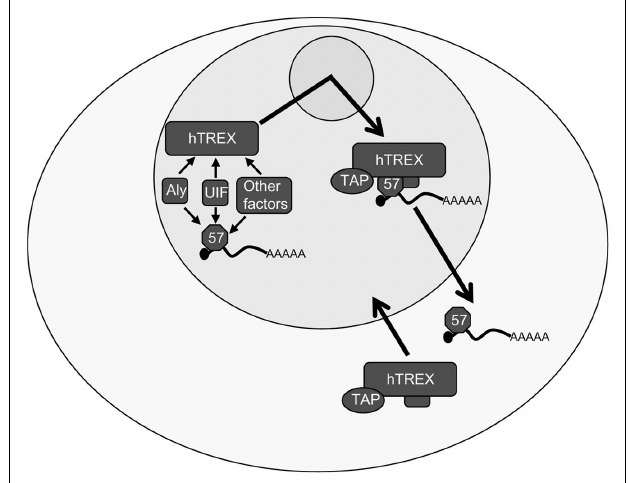
FIGURE 3 | Kaposi’s sarcoma-associated herpesvirus ORF57-mediated intronless viral mRNA nuclear export. ORF57 binds to intronless viral mRNA in the nucleus and interacts directly with the export adapters Aly and UIF.Via the interaction with one or both of these export adapters ORF57 can then recruit the remainder of the hTREX complex, including the proteins UAP56 and theTHO complex as well as the export receptor,TAP. ORF57 shuttles this complex through the nucleolus prior to the mRNA being exported into the cytoplasm in aTAP-dependent mechanism.The hTREX components are then recycled back into the nucleus while ORF57 remains bound to the viral mRNA for involvement in further downstream